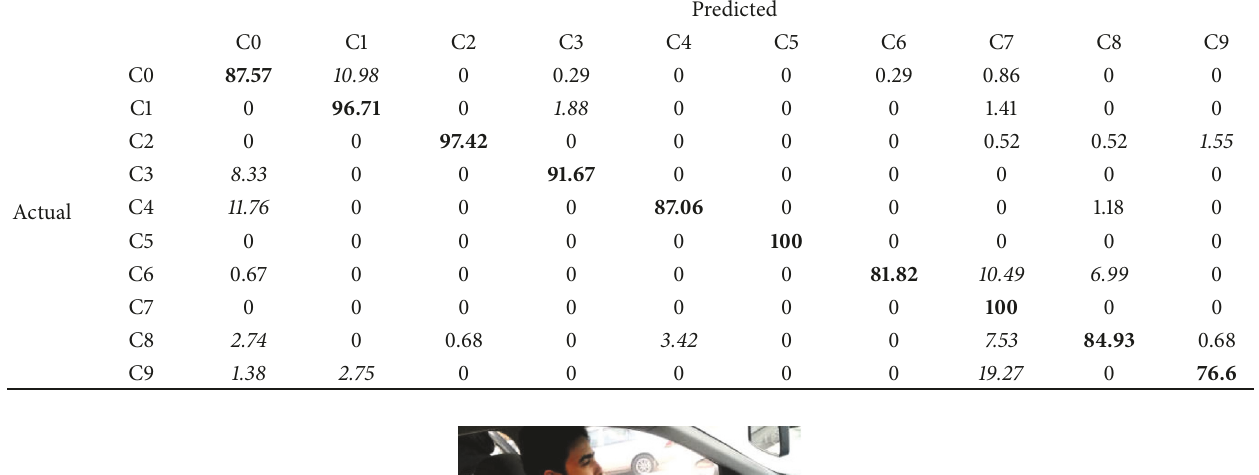
Table 5: Confusion matrix of InceptionV3 network on test data with unique drivers.